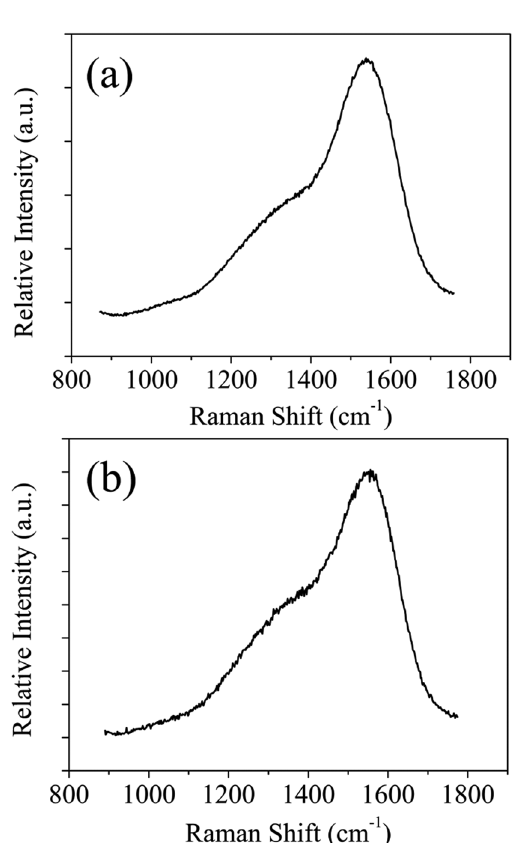
Figure 5: Raman spectra for DLC film obtained with (a) Active Screen Partial System, (b) Active Screen System. films adhesion increased almost linearly according to the bias voltage increase during silicon interface deposition. Similar results of enhanced adhesion were also obtained by Ward 22